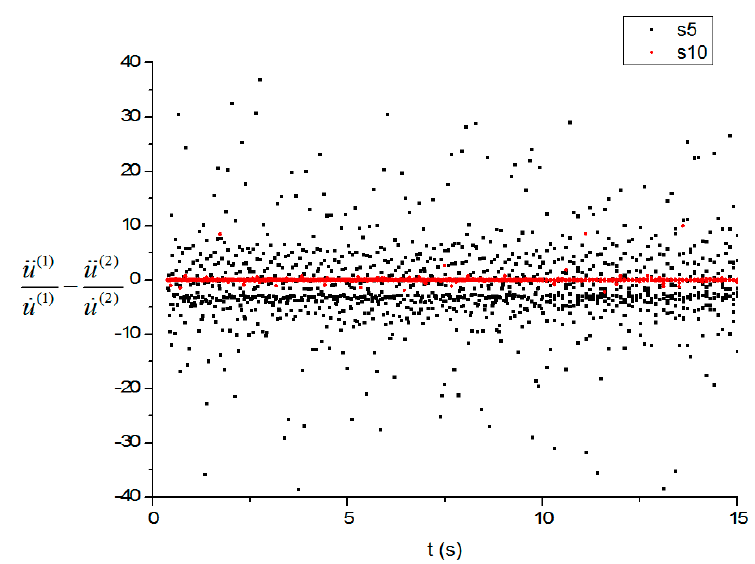
Figure 17. Function distribution of relative motion states at the soil-pile interface.